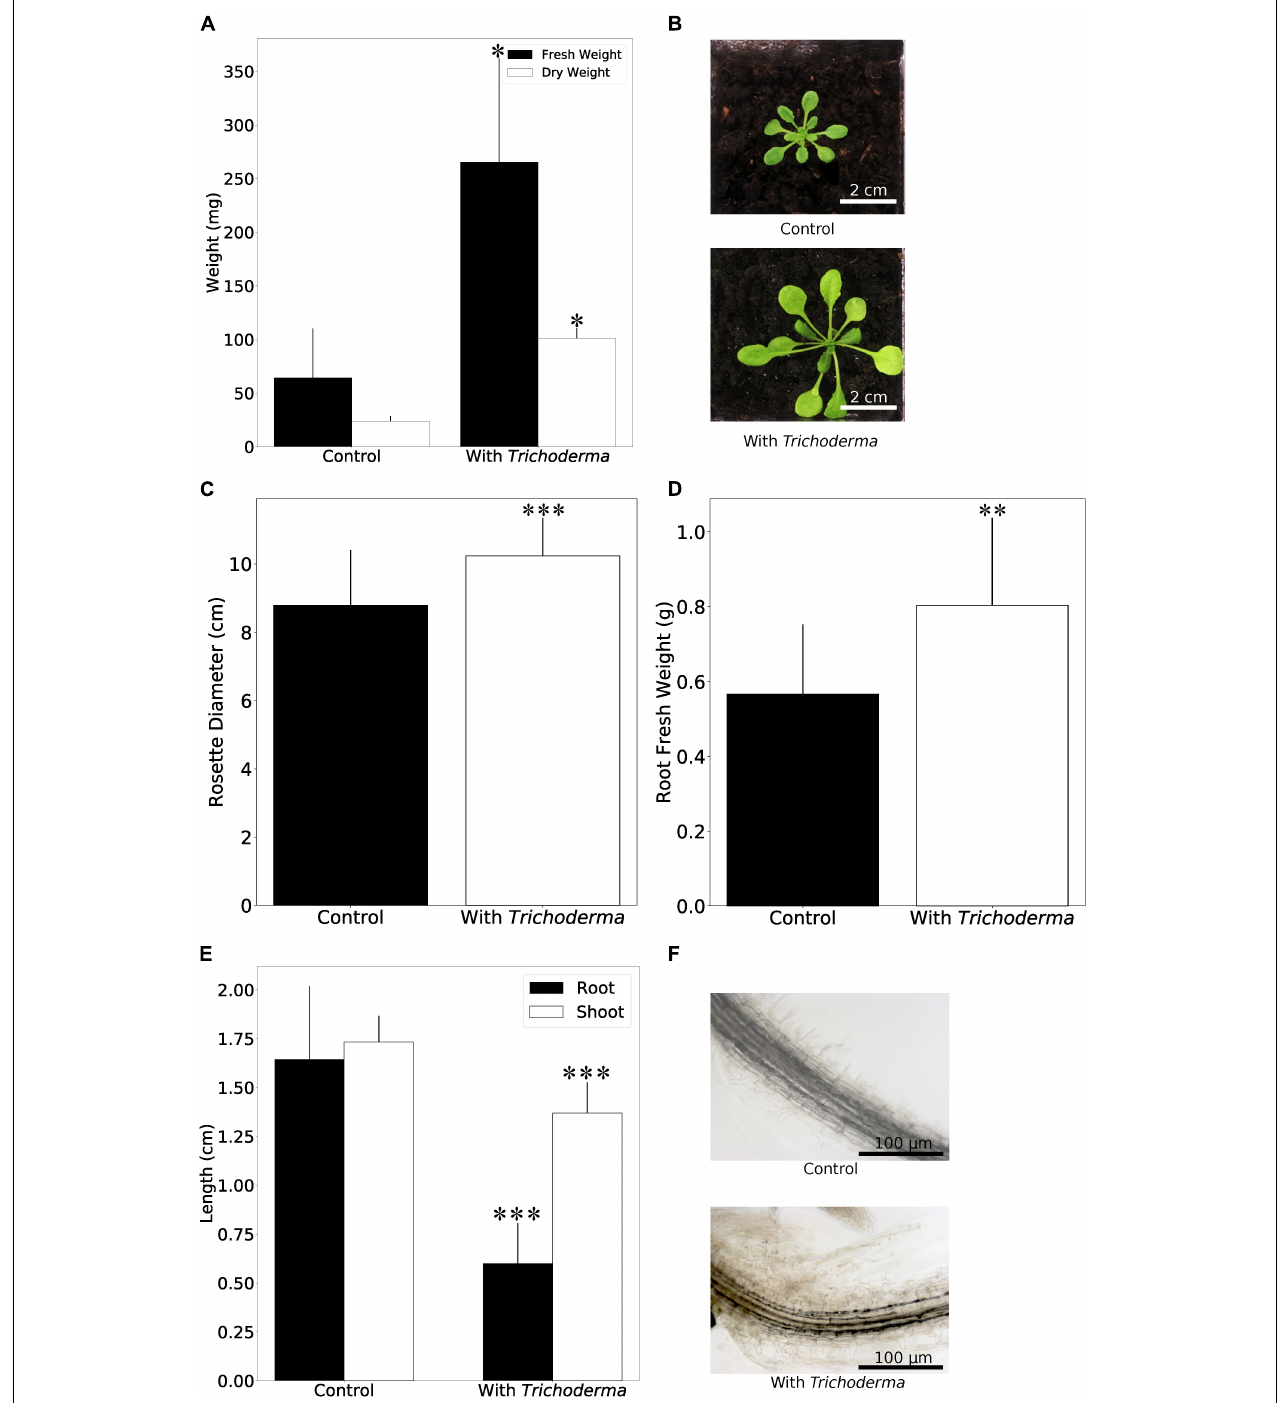
FIGURE 3 | Plant growth performance is influenced by Trichoderma colonization. (A) Fresh and dry weights of A. thaliana grown on soil with or without Trichoderma after 4 weeks. Error bars represent SEs from three independent biological replicates, each with four seedlings. Statistical significance was determined by Welch Two Sample t -test ( ∗ P < 0.05). (B) Growth promotion on A. thaliana on soil after 4 weeks. (C,D) Rosette diameter (C) and root fresh weight (D) of N. attenuata inoculated with or without Trichoderma on soil after 4 weeks. Error bars represent SDs from 39 independent biological replicates for shoots and 18 replicates for roots. Statistical significance was determined by Welch Two Sample t -test ( ∗∗ P < 0.01; ∗∗∗ P < 0.001). (E) Shoot and root lengths of N. attenuata 12 days after co-cultivation with Trichoderma (spore solution O.D. 600 nm = 0.0135) or without Trichoderma on Petri dishes. Error bars represent SDs from 10 biological replicates. Statistical significance was determined by Welch Two Sample t -test ( ∗∗∗ P < 0.001). (F) Microscopy of N. attenuata roots 12 days on Petri dishes with or without Trichoderma .